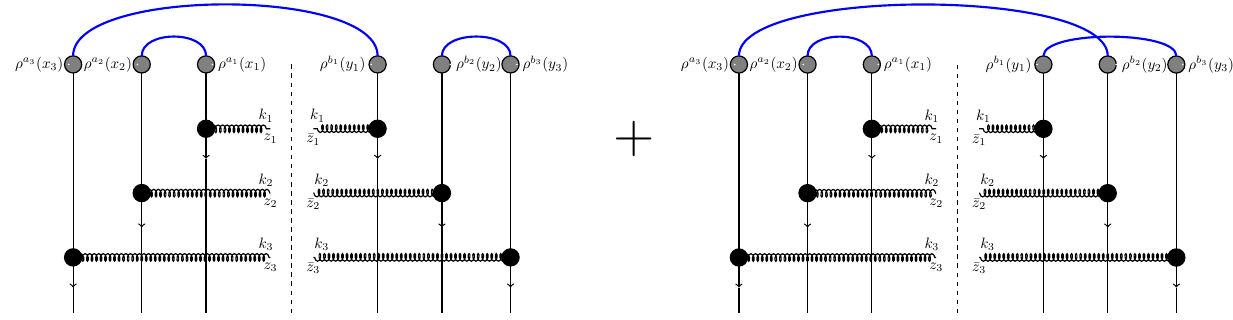
(cid:24) (cid:23) ρ a 1 ρ a 2 in the sextupole contribution x 1 x 2